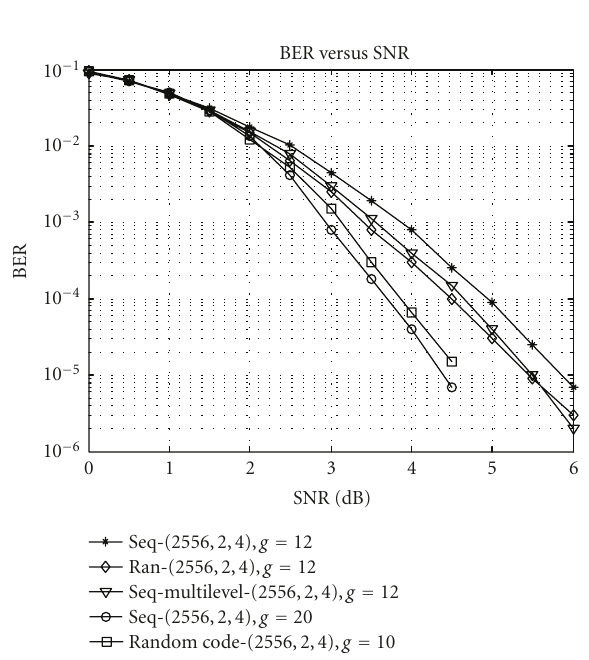
Figure 9: BER performance of obtained codes with 35 iterations.